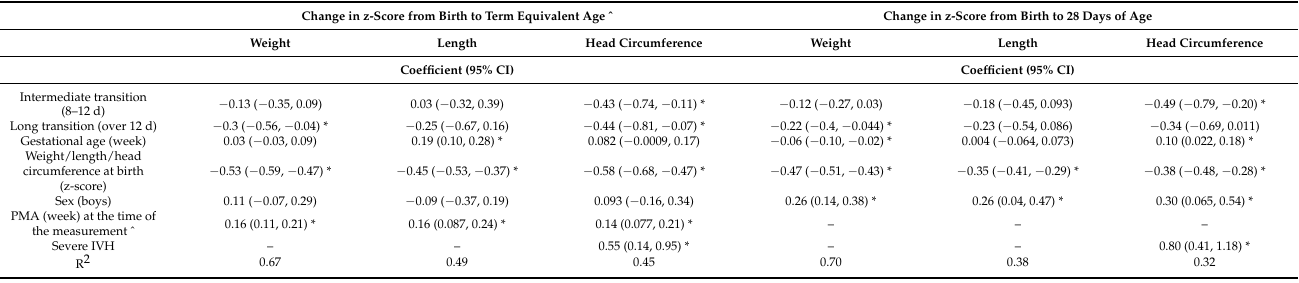
Table 3. Associations between transition phase length and postnatal growth (linear model). Short transition length up to 7 days was set as reference